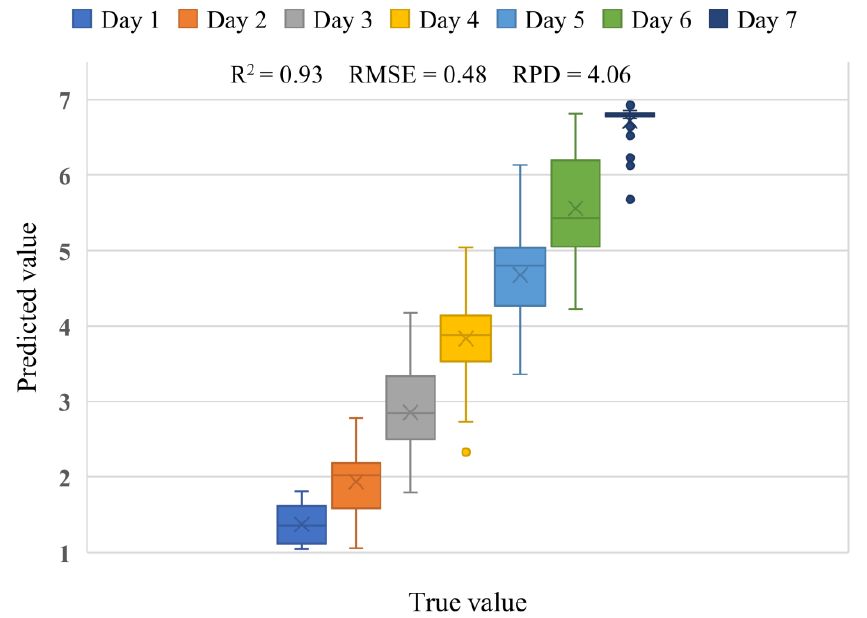
Figure 5. Box plot of the true values of shrimp storage days and predicted value of attention-based LSTM LSTM model.